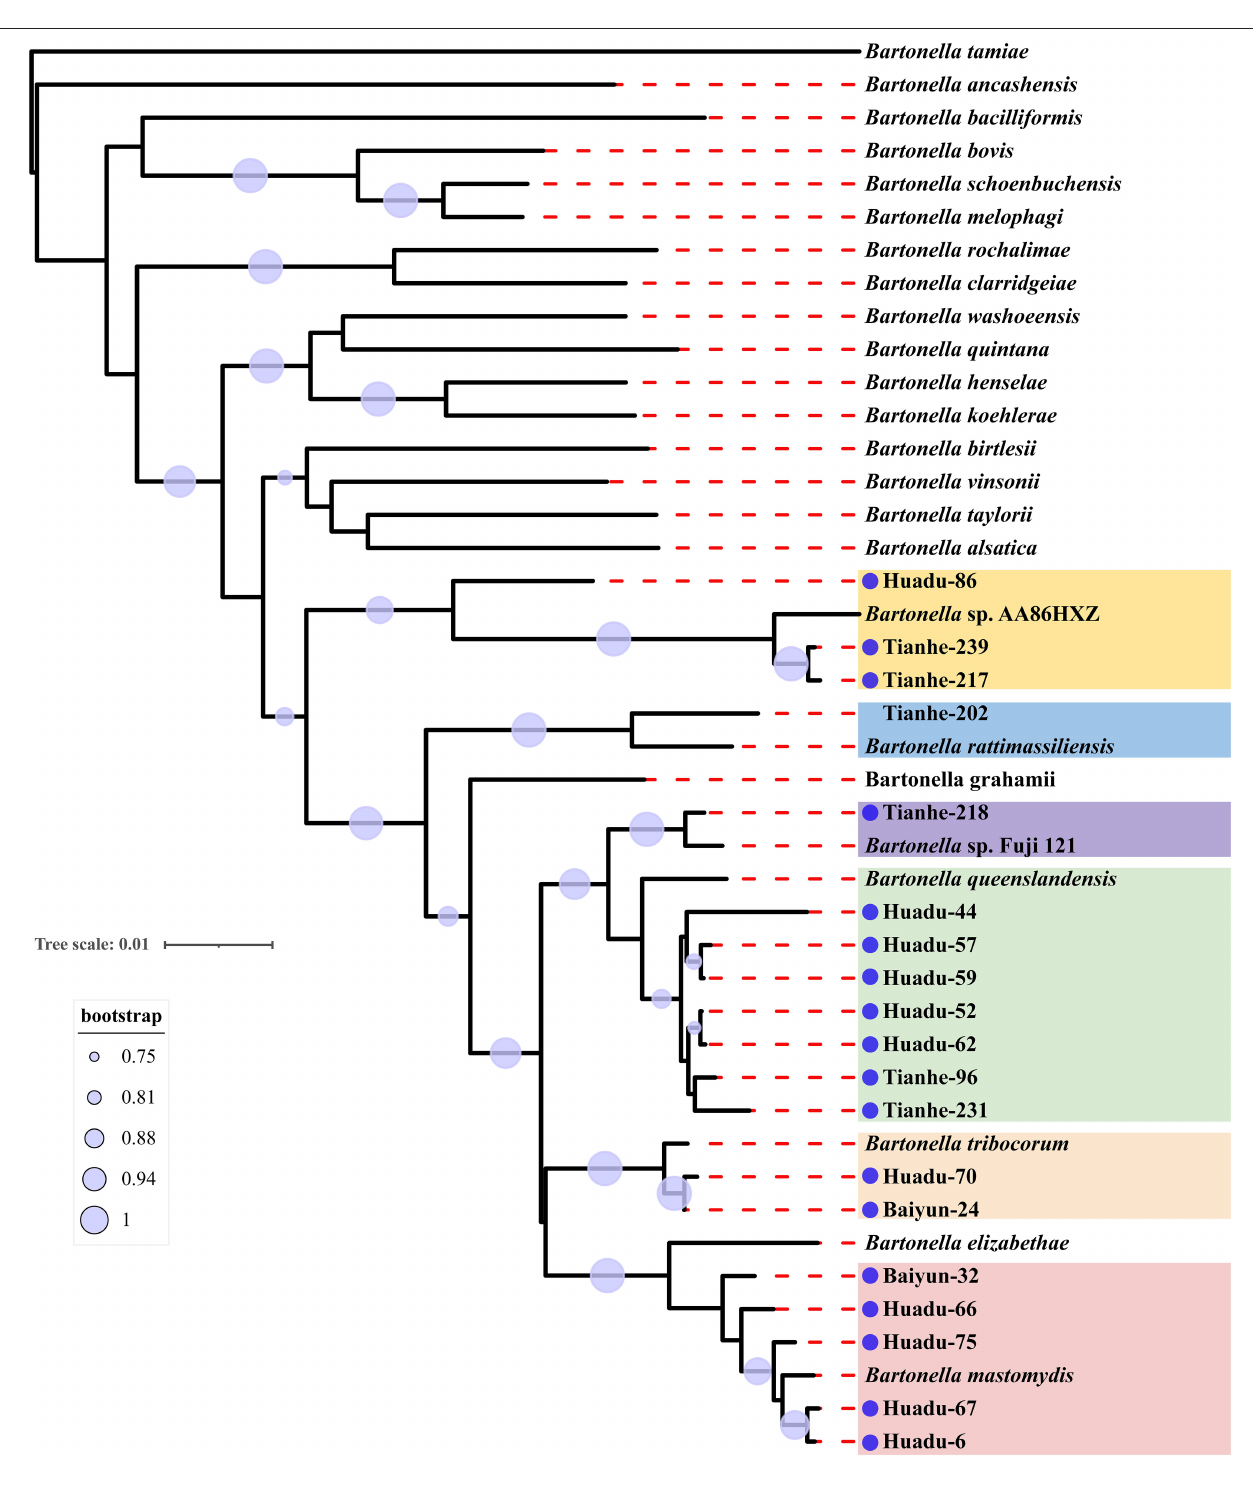
FIGURE 3 | Maximum-likelihood phylogenetic tree reconstructed based on the concatenated nucleotide sequences of rrs , gltA , and rpoB genes of Bartonella . Bootstrap values were calculated with 100 replicates of the alignment, and only bootstrap values > 70% are shown at appropriate nodes. Sequences of Bartonella determined in this study are marked with blue